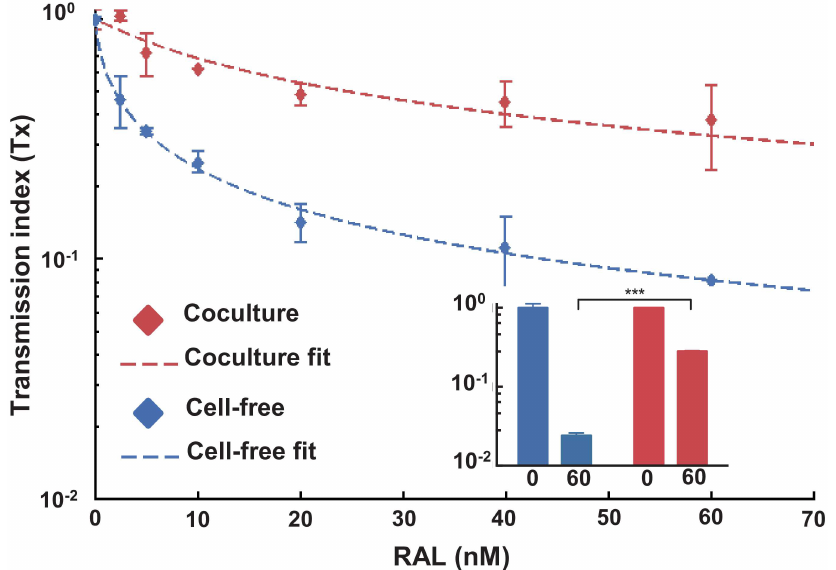
Fig 6. Decreasedsensitivity of coculture HIV spread to RAL predicts multiple infections per cell. Sensitivity of coculture (red) and cell-free (blue) infection to the integrase inhibitorraltegravir (RAL) in PBMCs. Points are means and standard errors of duplicatesfrom one of three experiments with different blood donors. Transmission index (Tx) was calculatedas the number of infected target cells with RAL divided by the number of infected target cells without RAL. Blue dashedline represents parametrization of the cell- free infection response to RAL in terms of IC 50 (1.9 nM) and hill coefficient (0.7). Red dashed line represents the fit of coculture infection using the decreasedsensitivity to RAL (Materials and methods). An effective MOI of 4.8 is predicted for coculture infection. Inset: Sensitivity of primary CD4 + T cell infection to RAL. Points are Tx means and standard errors of duplicatesfrom one of three experiments with different blood donors. The drug sensitivity differences in CD4 + T cells between cell-free and coculture was statistically significant (p < 0.001, two-tailed